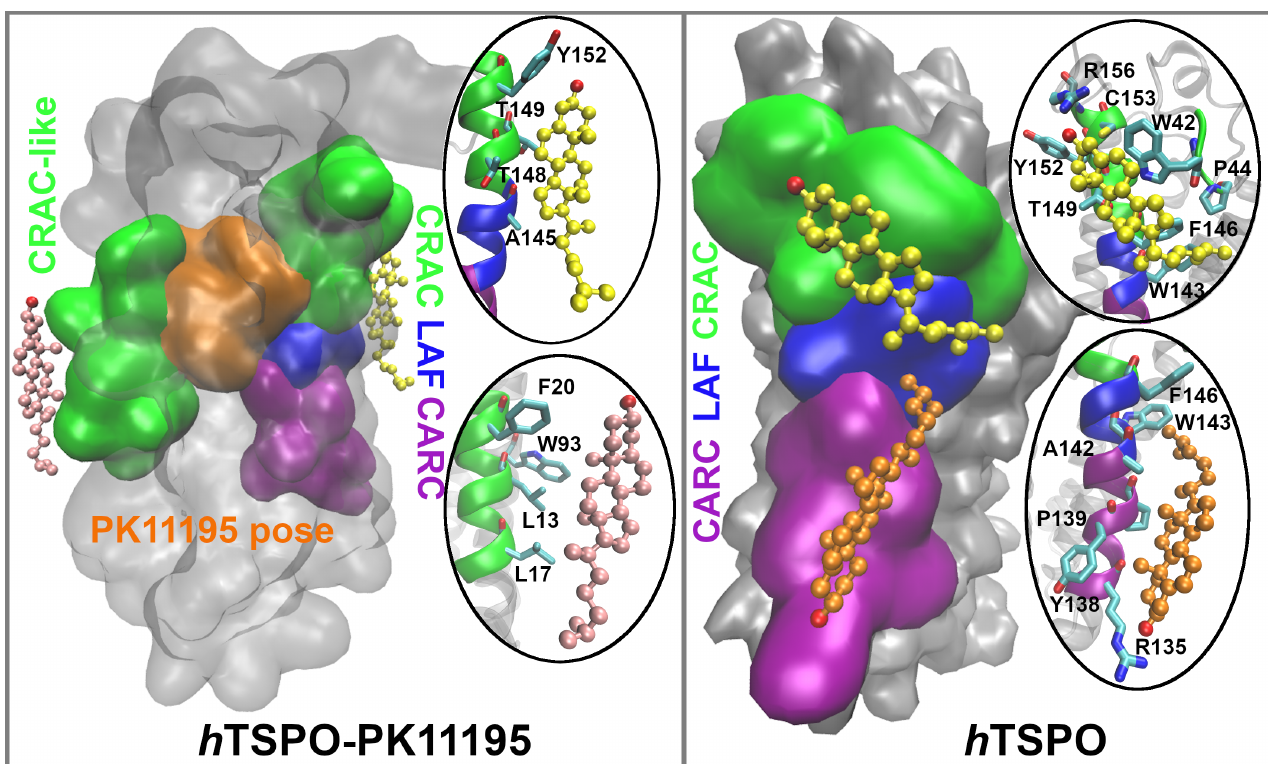
Figure 8. Cholesterol molecules bind most frequently to CRAC and CRAC–like regions (green surface representation) that are in the vicinity of the PK11195 binding site (orange surface representation) in the h TSPO–PK11195 system and to CRAC, LAF(blue surface representation), and CARC (purple surface representation) motifs in the h TSPO system. Corresponding residues from each region that interact with cholesterol (color coded, respectively) are represented within